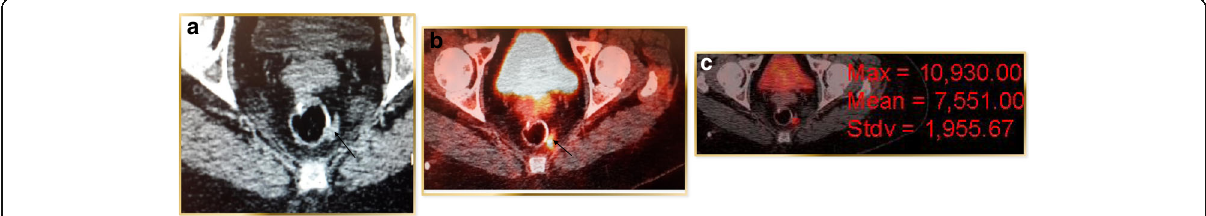
Fig. 4 a Post-operative CT study showing left para rectal soft tissue lesion (black arrow) mostly nodal. b PET/CT fused image with avid uptake of the lesion (black arrow)using the visual assessment method. c PET/CT fused image with SUV max of the lesion 10 reflecting high metabolic activity impressive of nodal